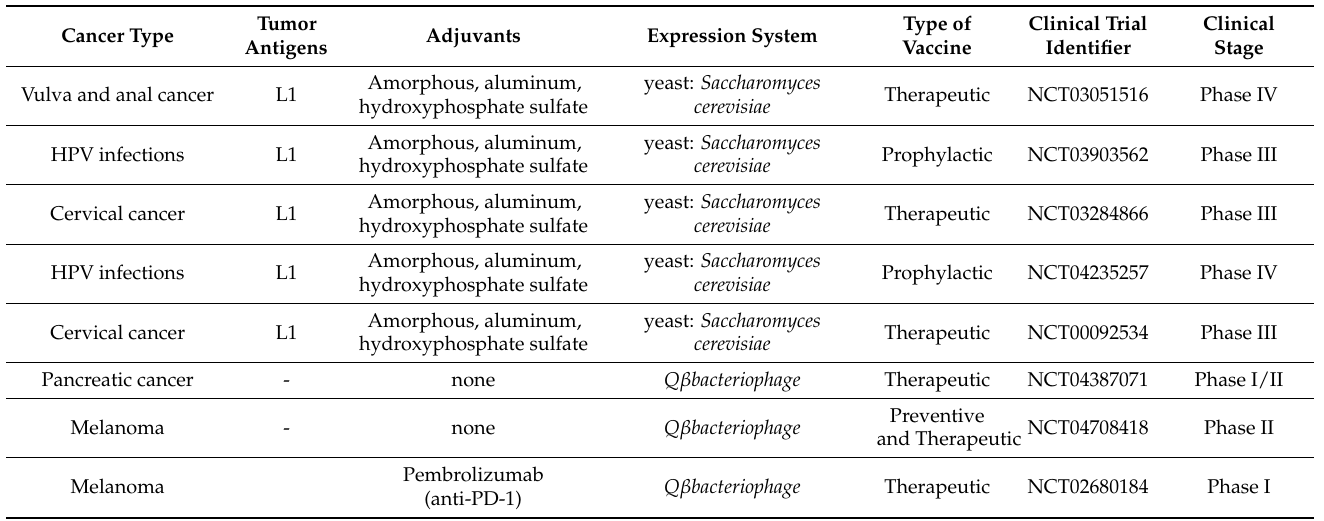
Table 4. VLP vaccines in clinical